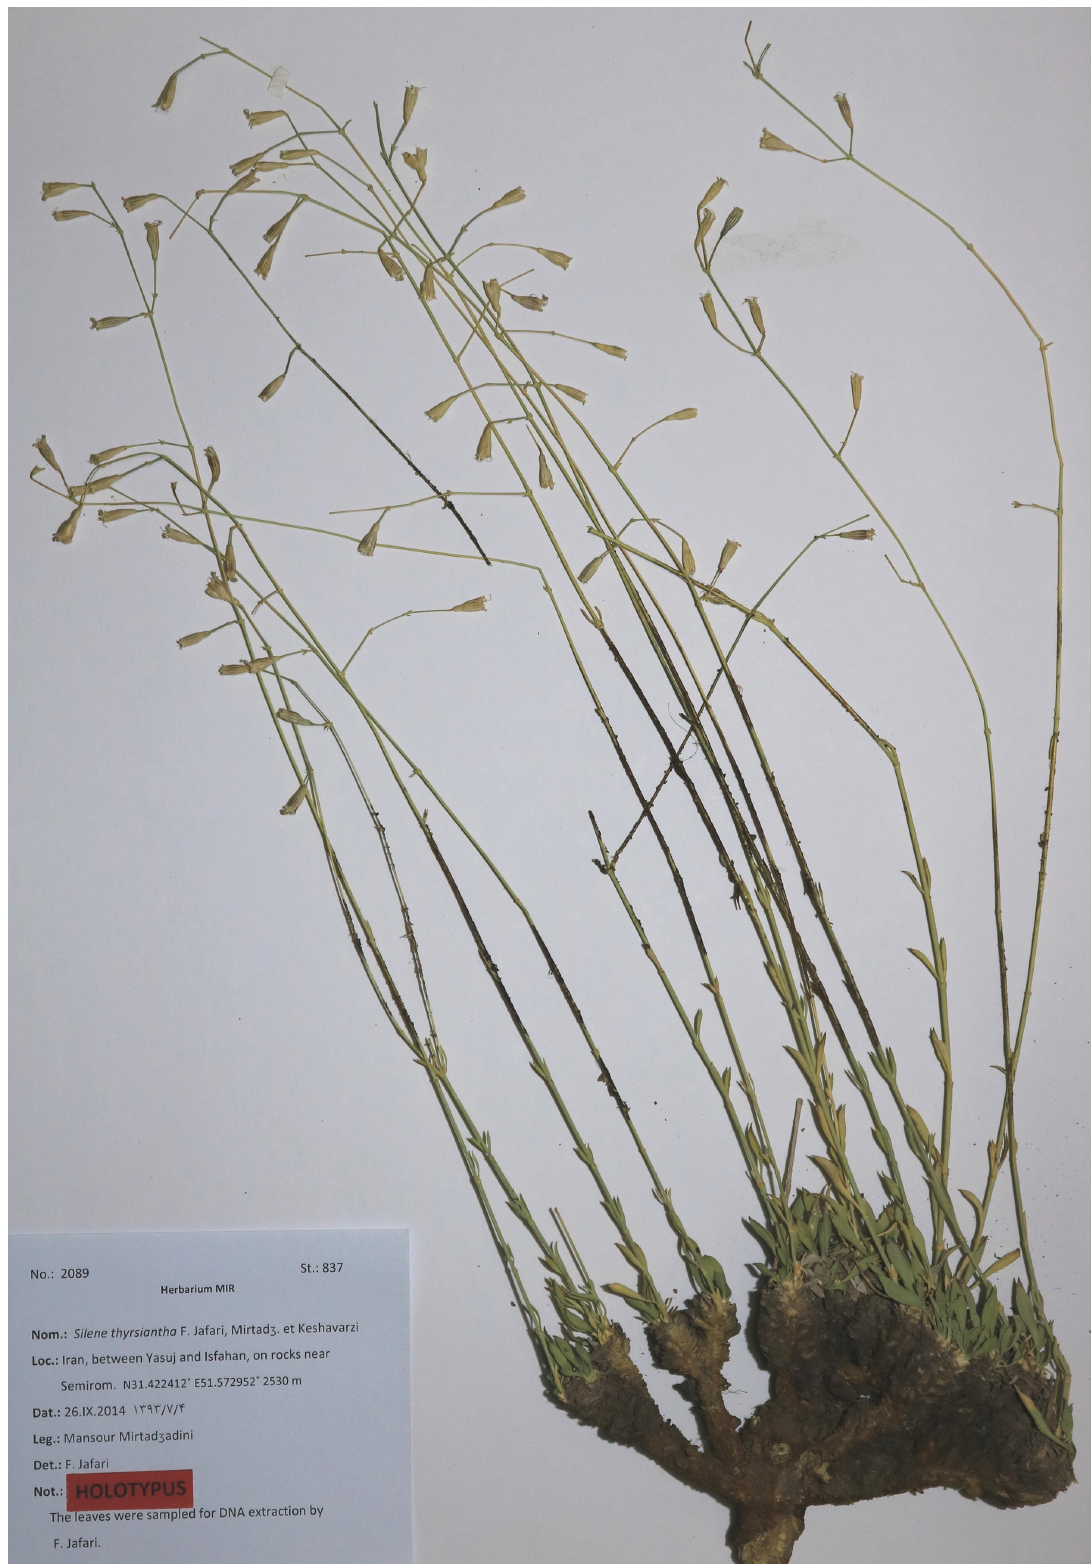
Fig. 5. Silene thyrsiantha F.Jafari, Mirtadz. & Keshavarzi sp. nov. (holotype, M. Mirtadzadini 2089 ;